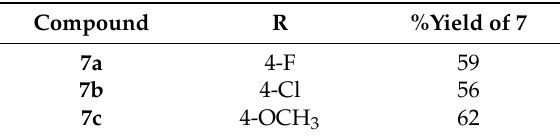
Table 6. Percentage yield of compounds 7a – c.